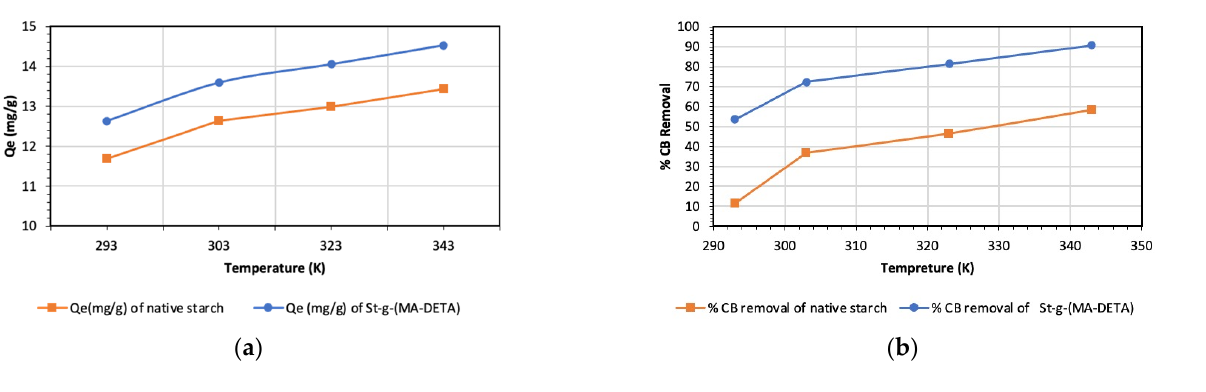
Figure 15. Effect of temperature on the adsorption capacity ( a ), and removal percentage ( b ) on the sorption of CB (dye concentration = 15 ppm, time = 120 min, pH = 7, adsorbent dose = 0.05 mg/L and V = 50 mL).